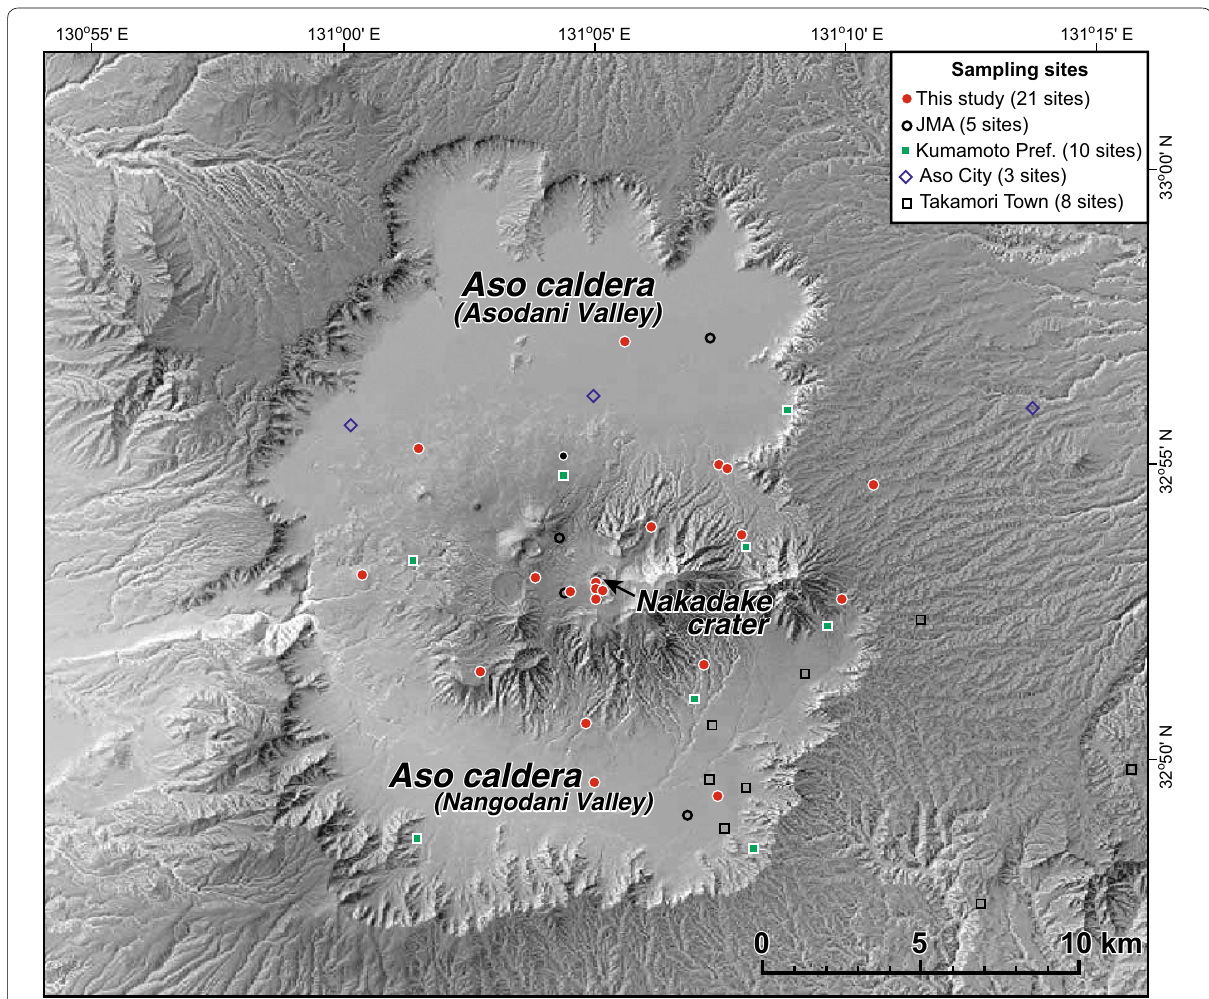
Fig. 2 Map showing locations of ash samplers in and around Aso caldera, southwestern